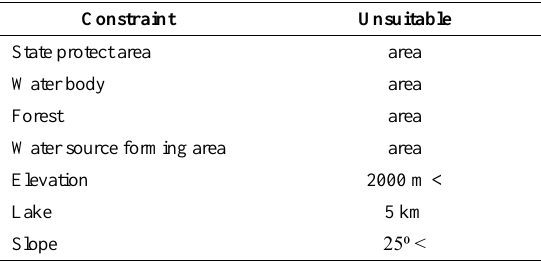
Table 2. Constraint factor